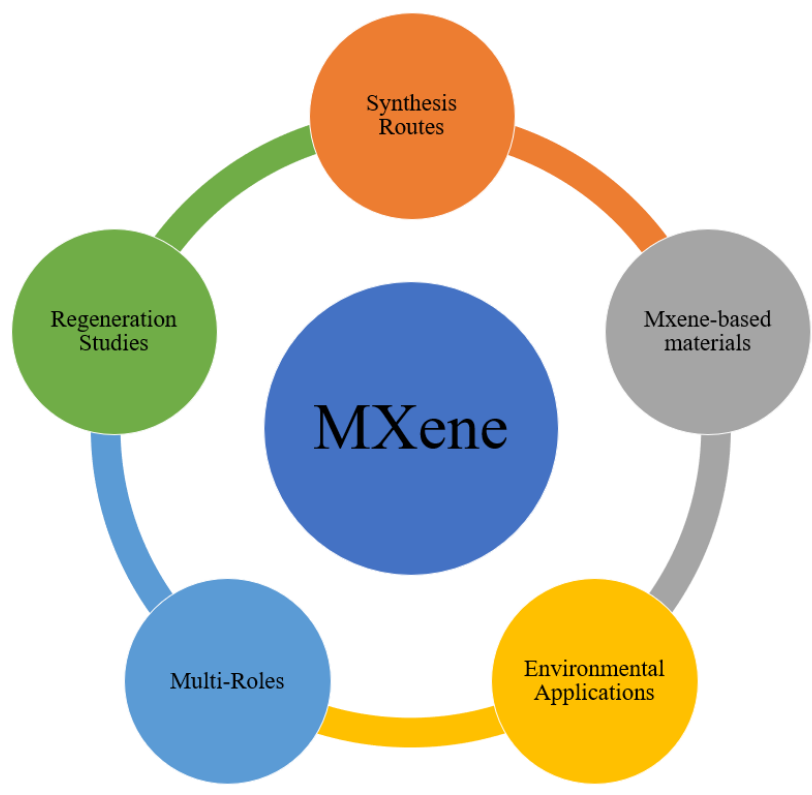
Figure 1. Significant features of MXene-based nanomaterials in the current review.